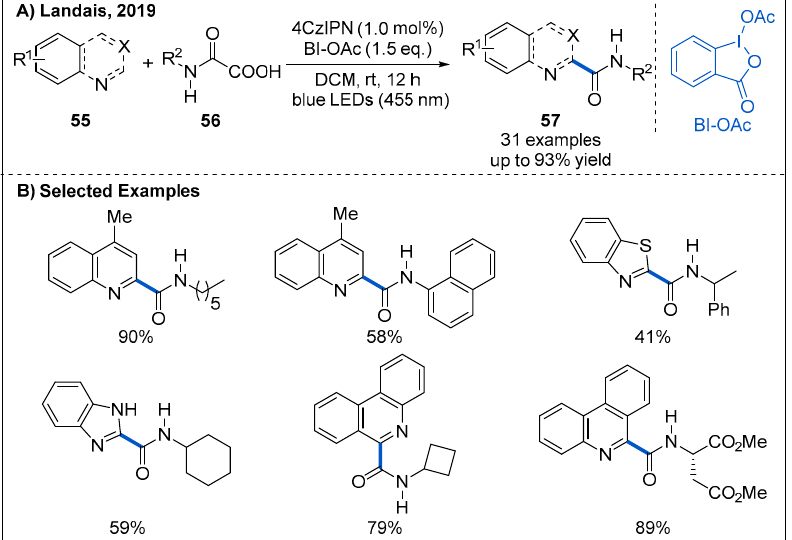
Figure 19. Amide synthesis by photoredox-catalyzed carbamoyl radical addition to heteroarenes.